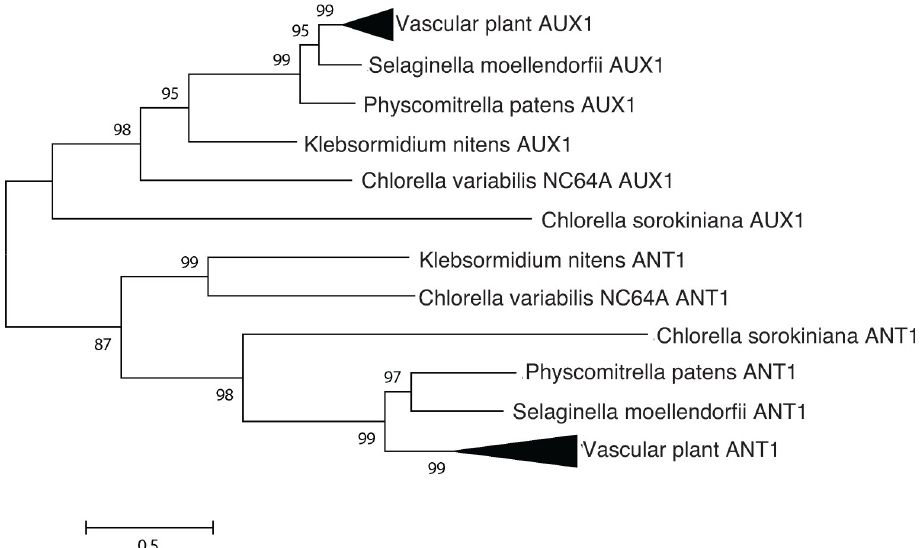
Fig 3. Phylogenetic analysis indicates sequence conservation of AUX1. AUX1, an AAP-like transporter specific for auxin transport, is compared with ANT1, an aromatic amino acid transporter in plants. Putative orthologs and outgroups were identified by reciprocal BLAST searches, aligned with Clustal Omega and analyzed using the LG+I substitution model in MEGA 6.06.